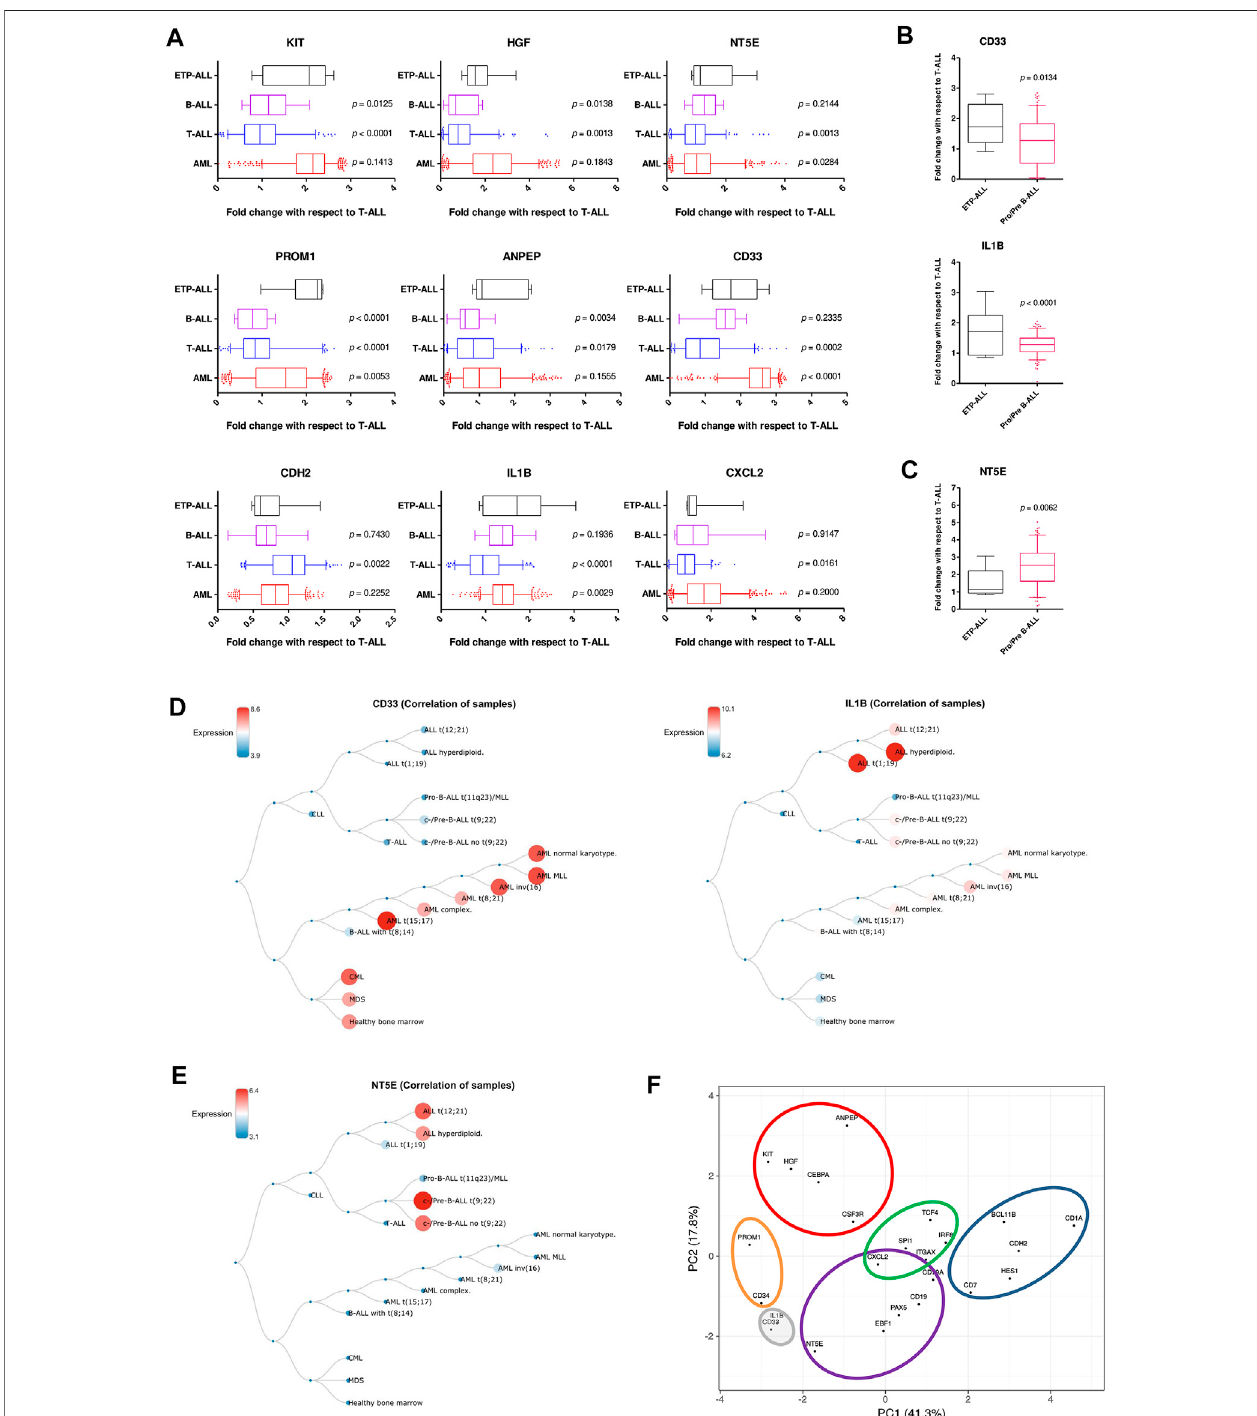
FIGURE7| ResemblanceinexpressionstatusoftheproposedbiomarkersinETP-ALLanddifferentleukemiasubtypes. (A) Foldchangeinexpressionlevelsofthe proposed biomarkers in ETP-ALL, B-ALL, T-ALL, and AML. (B) Fold change in expression levels of CD33 and IL1B in ETP-ALL and pro/pre-B-ALL. (C) Fold change in expression levels of NT5E in ETP-ALL and pro/pre-B-ALL. For (A – C) , Expression levels of the genes in ETP-ALL were derived from GSE28703 and normalized with respect to their mean expression values in non-ETP-ALL, while expression levels of the genes in pro/pre-B-ALL, B-ALL, T-ALL, and AML were derived from GSE13159 and normalized with respect to their mean expression values in T-ALL. (D) Correlation dendrogram of CD33 and IL1B expression levels across different leukemia subtypes from GSE13159. Constructed on BloodSpot. (E) Correlation dendrogram of NT5E expression levels across different leukemia subtypes from GSE13159. Constructed on BloodSpot. (F) PCA plot ofthe proposed biomarkers and standard lineage markers (from Figure 6A ) with lineage demarcation boundaries (orange: stemness, purple: B-lineage, blue: T-lineage, green: dendritic cell, red: myelo-monocytic, grey: unclear lineage skew), drawn on the basis of the consolidated outcomes. Two-tailed unpaired Student ’ s t-test was used to calculate the statistical signi fi cance, wherever applicable.